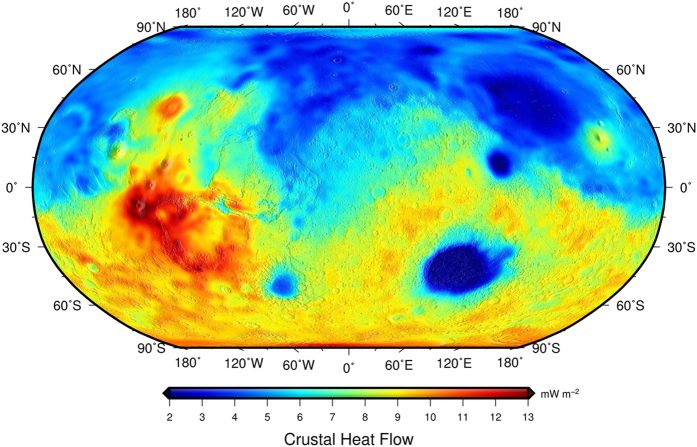
Global crustal heat flow on Mars (sampled on a 2° × 2° grid) derived from an average surface heat production based on the GRS-measured abundances of HPEs182124, an average uniform crustal density of 2900 kg m−3, and our crustal thickness model.